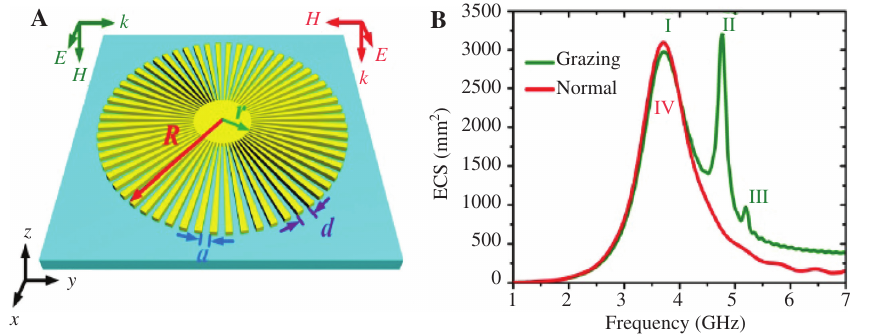
Figure 27: Textured metallic disk and the resonance properties. (A) Ultrathin spoof LSP structure based on a thin dielectric substrate, in which R = 10.5 mm, r = 2 mm, d = 1.1 mm, a = 0.55 mm, and the number of grooves N = 60. (B) The simulation ECS spectra for grazing and normal incidences. The green and red lines correspond to the grazing and normal incidence, respectively. Reproduced from [49] with